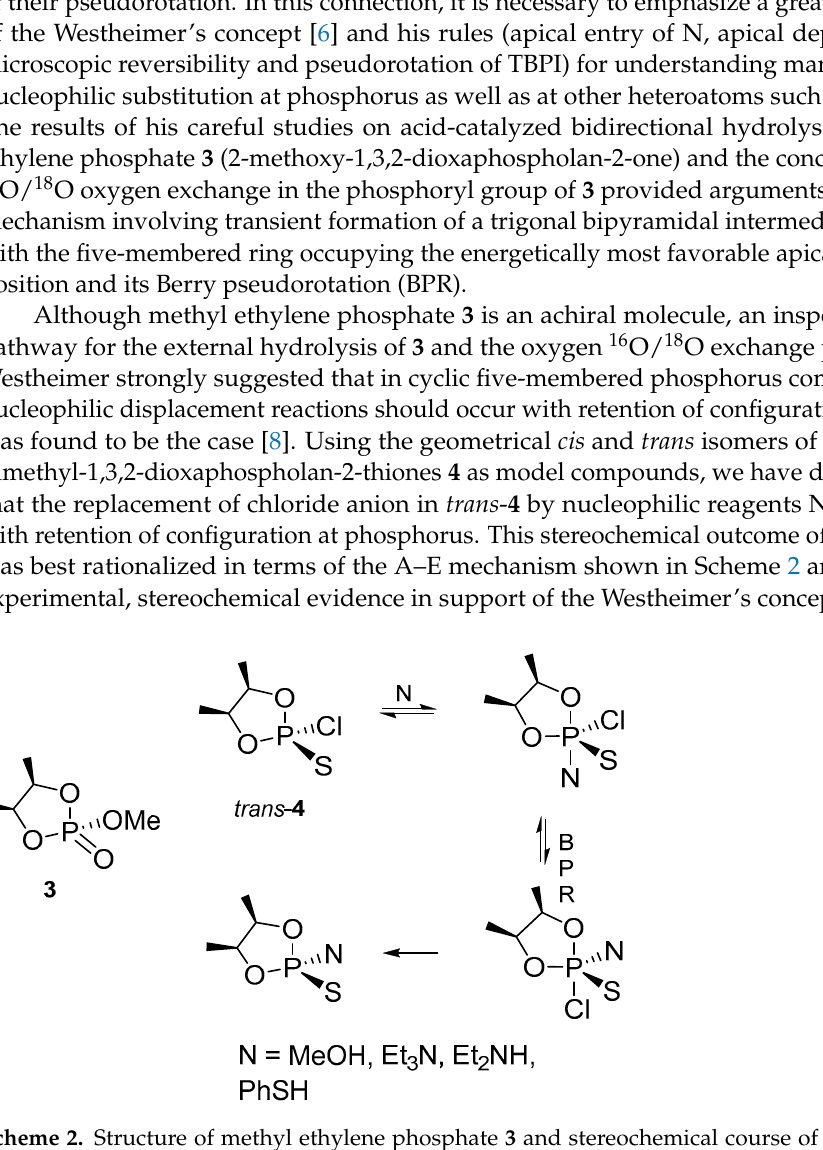
Scheme 2. Structure of methyl ethylene phosphate 3 and stereochemical course of